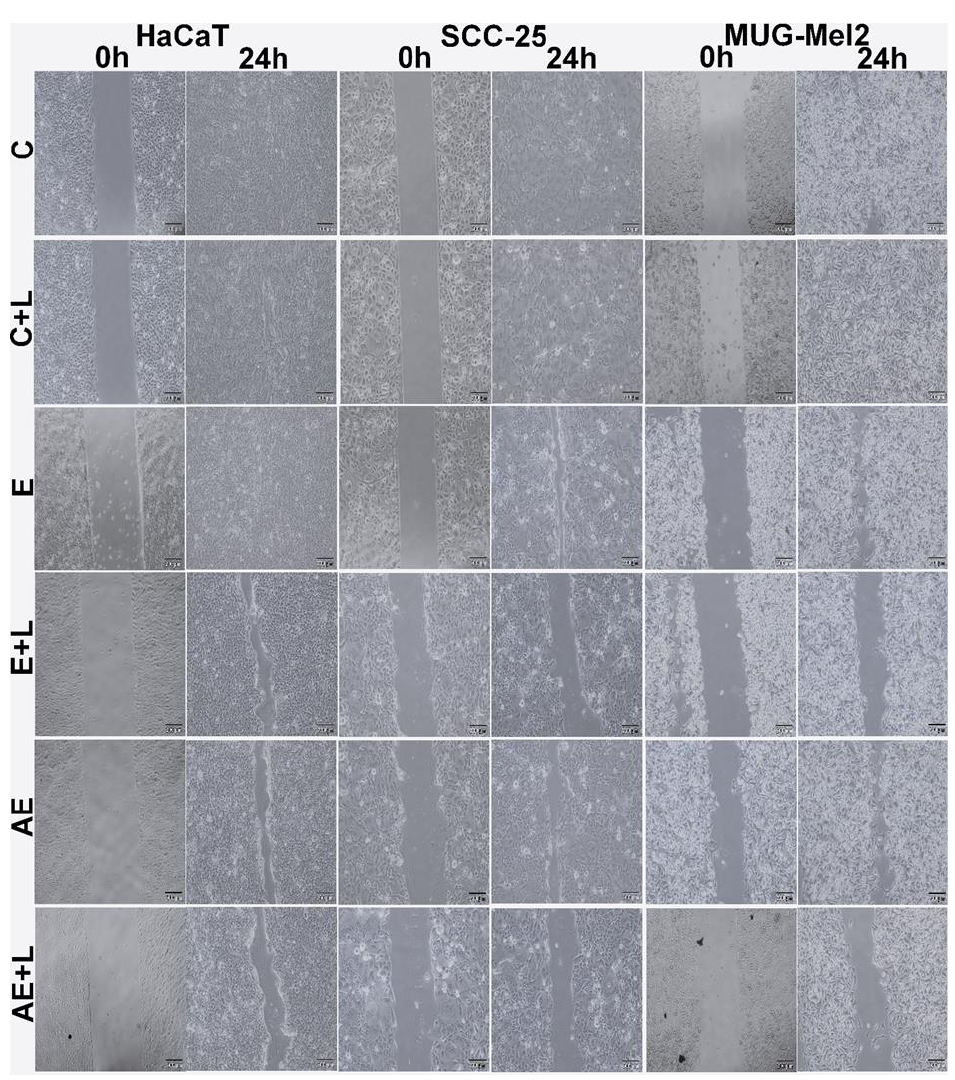
Figure 4. Wound-healing assay in time point 0 h and 24 h of HaCaT, SCC-25, and MUG-Mel2 cell line. Representative images show that, in SCC-25 and MUG-Mel2 after 24 h, the scrap in control cells is minimal compared to treated cells with emodin (E) or aloe-emodin (AE) in dose 20 µM with blue light (L) (6 J/cm 2 ). In treated cells, in the HaCaT control cell line, the scrap is smaller than in the other two cancer cells. Scale bar = 200 µm.